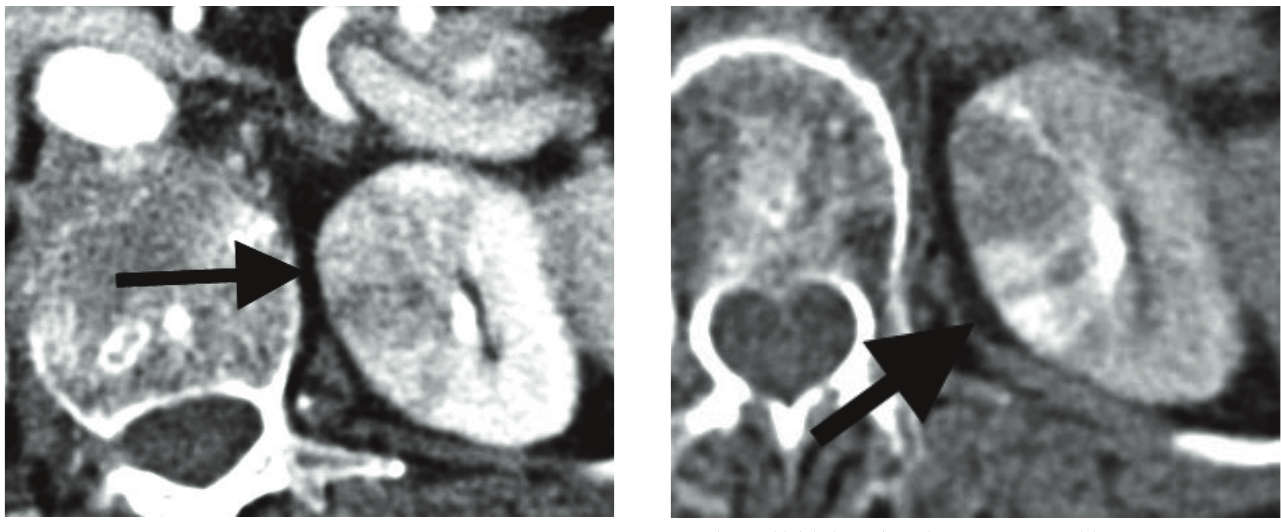
Fig. 3b. Axial left kidney after 3-hour post-contrast